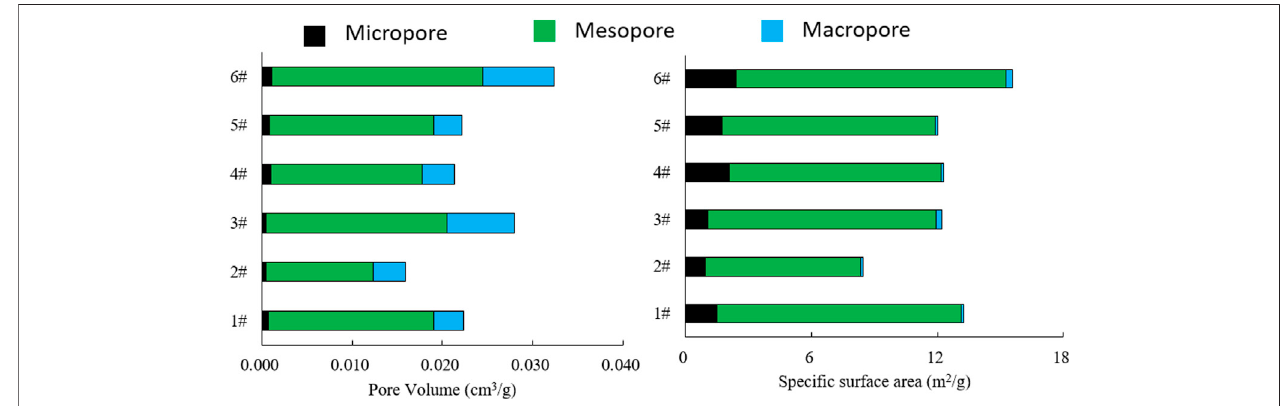
FIGURE 5 | Distribution of pore volume and speci fi c surface area of samples.